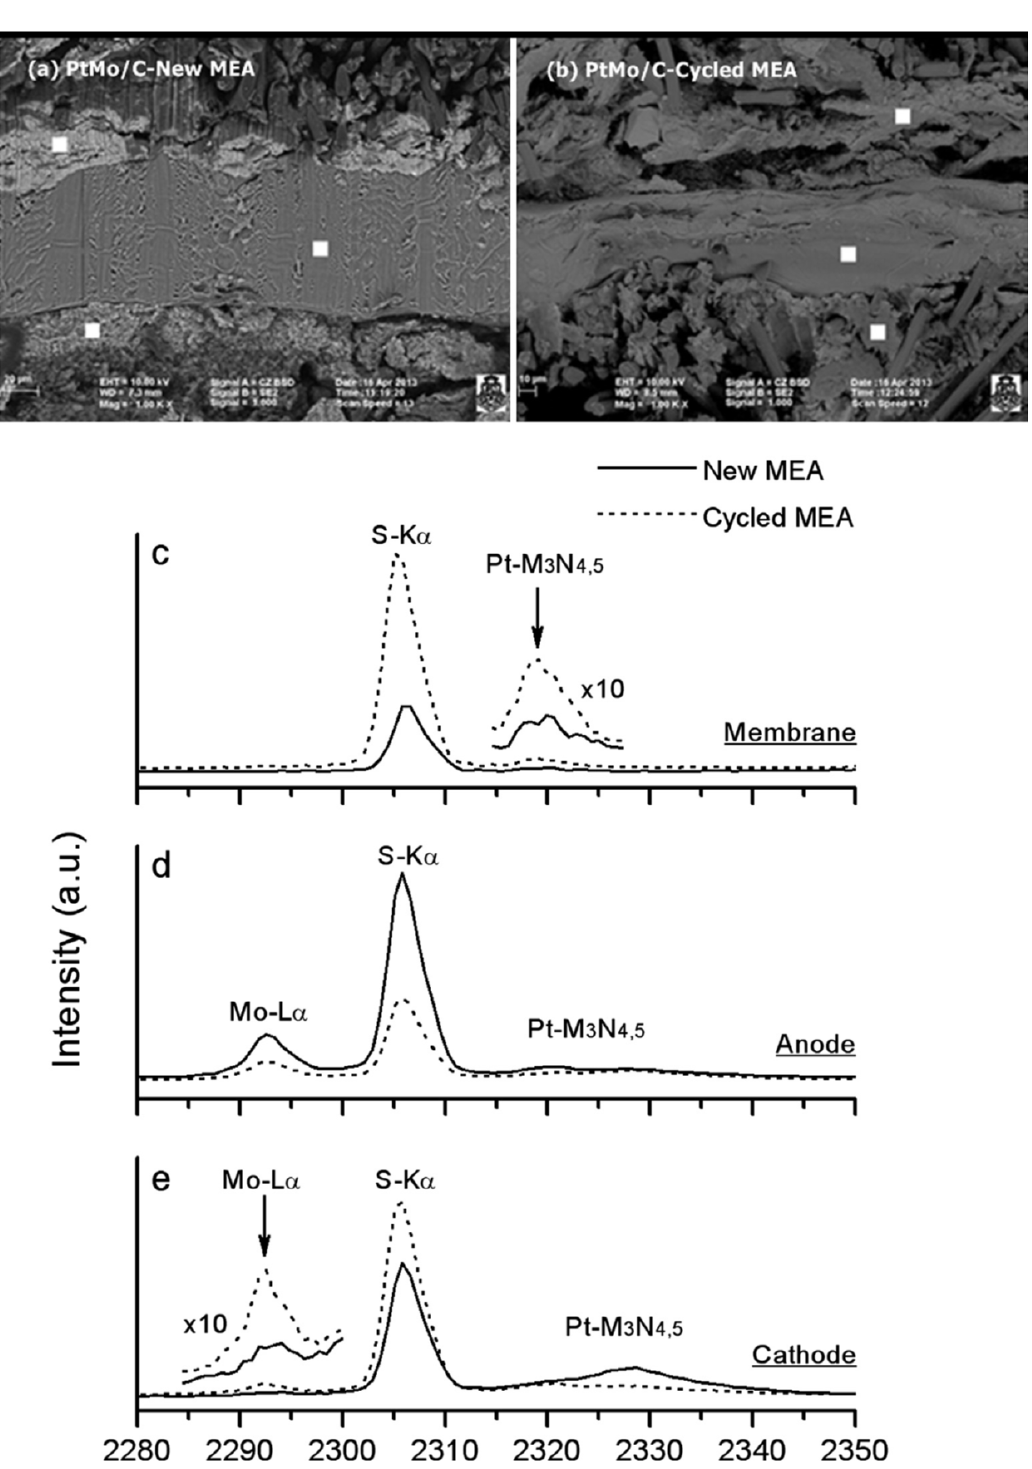
Figure 12 - Scanning electron micrographs of cross sections of the new ( a ) and cycled ( b ) MEAs, recorded with backscattered electrons. WDS spectra of the membranes ( c ), anodes ( d ) and cathodes ( e ) of both MEAs, acquired with a 20 keV incident electron beam, in the energy range between 2.28 and 2.35 keV, corresponding to the areas indicated with the white spots in the micrographs (a) and (b). (Reprinted with permission from Hassan et al.